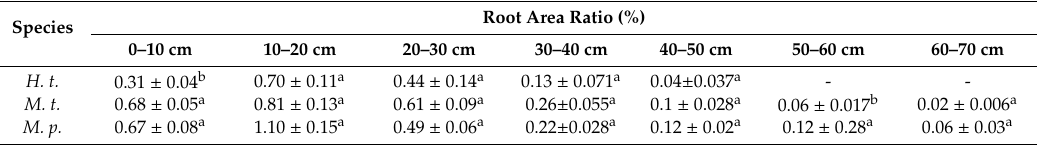
Figure 1. Typical root system architecture of 1-year-old Hibiscus taiwanensis ( a ) , Macaranga tanarius ( b ) and Mallotus paniculatus ( c ) seedlings. Table 2. Means  standard deviations of root area ratio at different soil depths for the three species Table 2. Means ± standard deviations of root area ratio at di ff erent soil depths for the three studied. species studied.